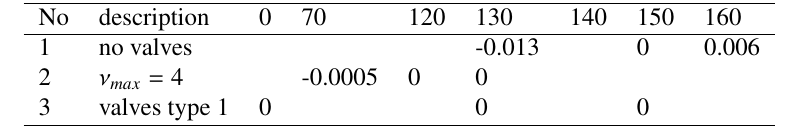
Table 1. Results of calculations of the test